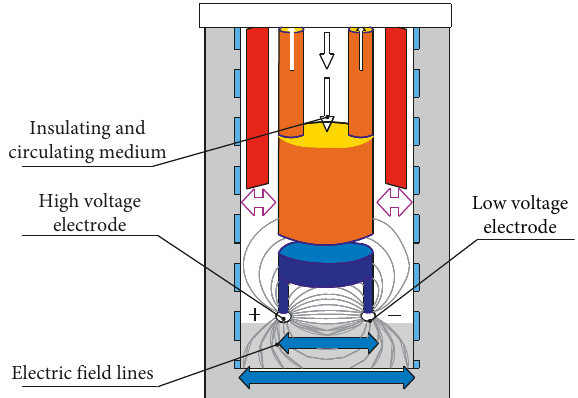
Figure 1: Schematic representation of electro-pulse rock